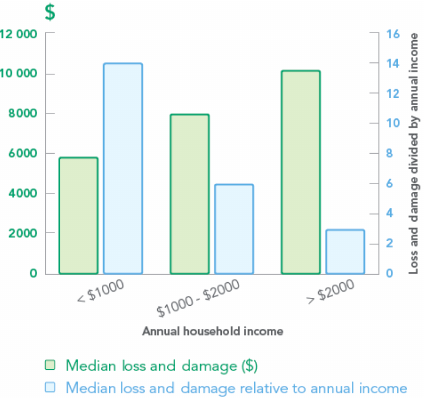
Figure 2. Monetary loss and damage by income group.